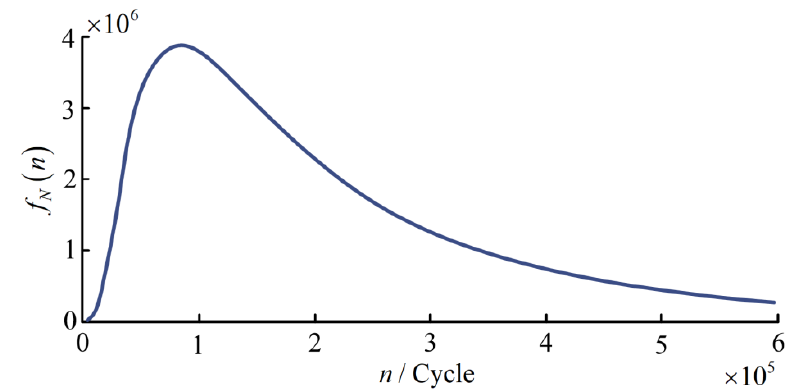
Figure 4. Probability density function curve of fatigue life of Ti-6246.